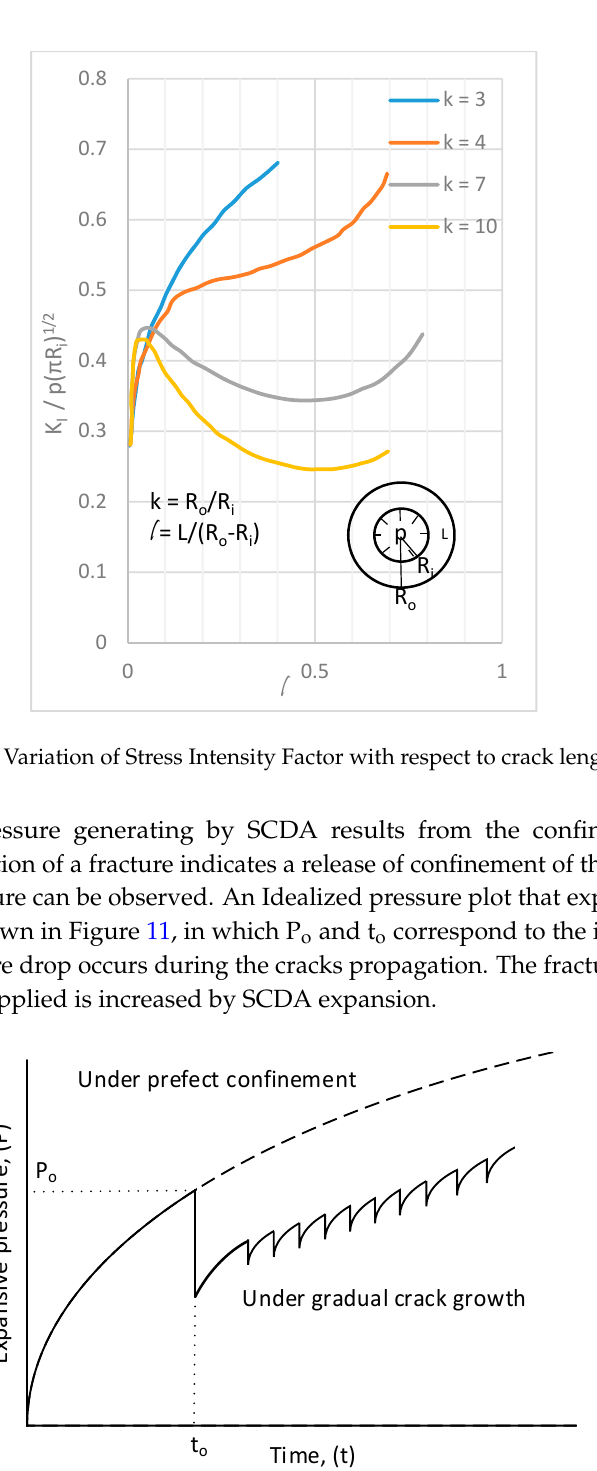
Figure 11. Possible pressure growth with time [64].